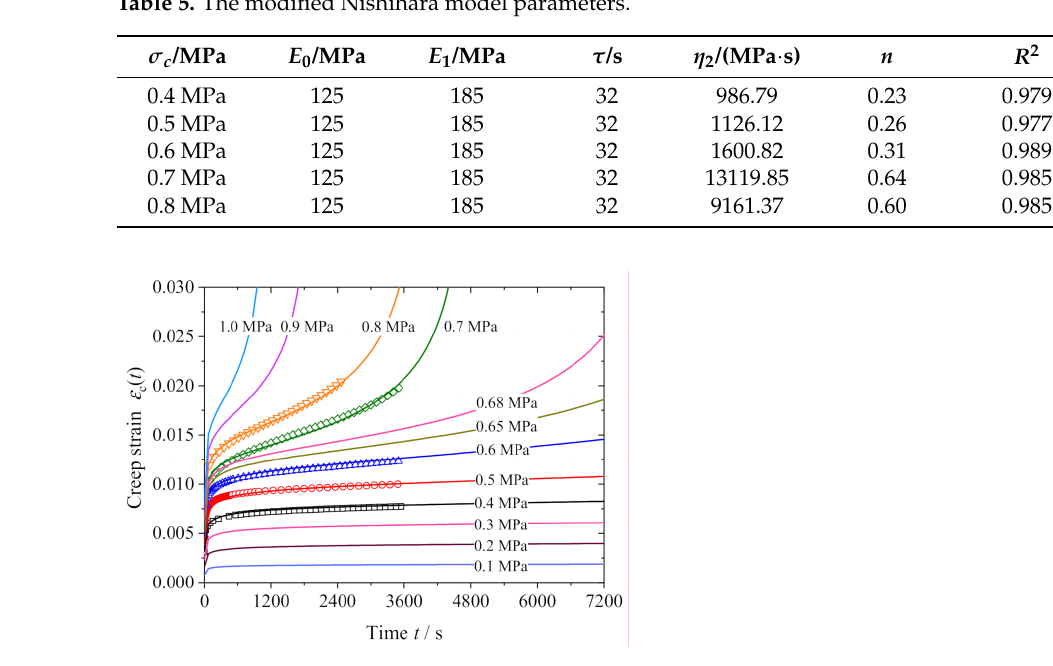
Figure 9. NFVEP model predictions at various